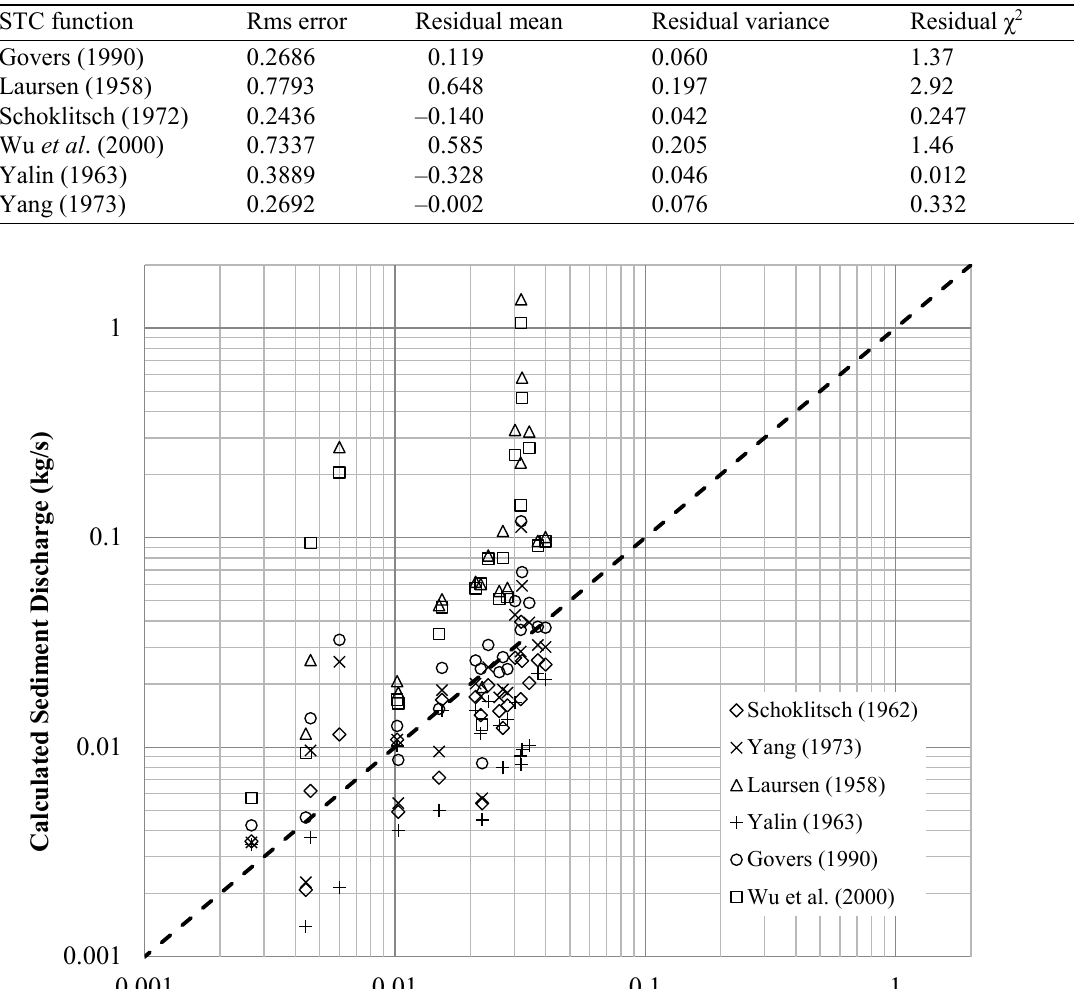
Table 2 Root mean square error and residual statistics (using log10 transformed data) of the evaluated STC functions.